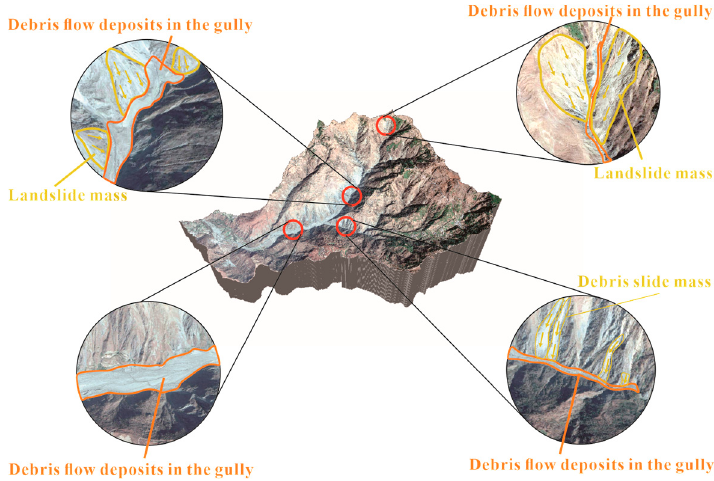
Figure 8. Examples of remote sensing image interpretation of debris flows. In the process of interpretation, the debris flow accumulation is an important symbol of interpretation. At the same time, the landslide mass on both sides of the gullies can provide rich material source conditions for the occurrence of debris flows, which can also provide important reference for the interpretation of debris flows.